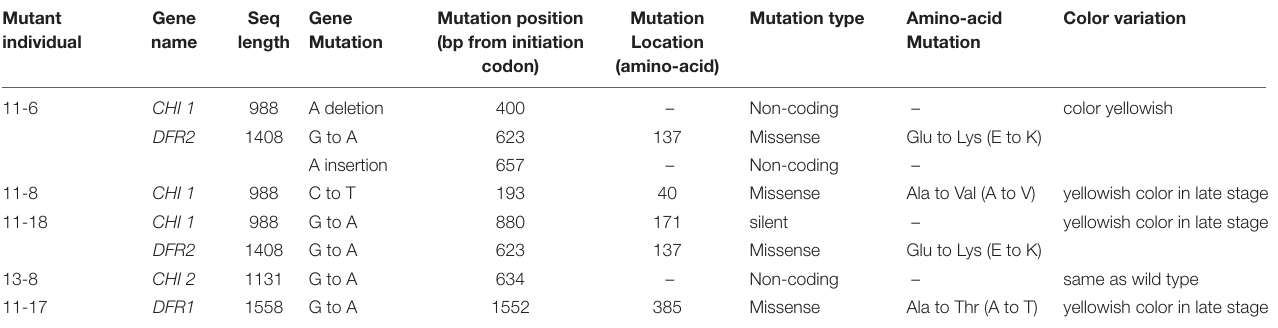
FIGURE 3 | An example of HRM analysis in each figure, the upper curve reflects the difference in dissolution curves after removing differences among the different holes, and the lower curve shows the changes in fluorescence that occurred during the process of dissolution. The default value is the change in wild type (gray line), which allows the detection of changes in mutant (colored lines) and wild type plants at the same fluorescence level. (A) CHI1 test results. The red line is 11-6, the blue line is 11-8 and the green line is 11-18. (B) DFR2 test results. The blue line is 11-6 and the green is 11-8, the color is different for different point mutations. (C) CHI2 test results. The red line is 13-8. (D) DFR1 test results. The red line is 11-17. TABLE 3 | Individual mutants identified by HRM that were confirmed by DNA